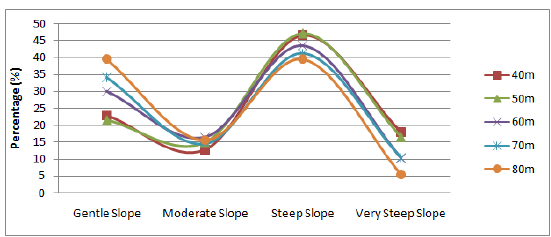
Figure 10. Slope Attributes at Different Altitude